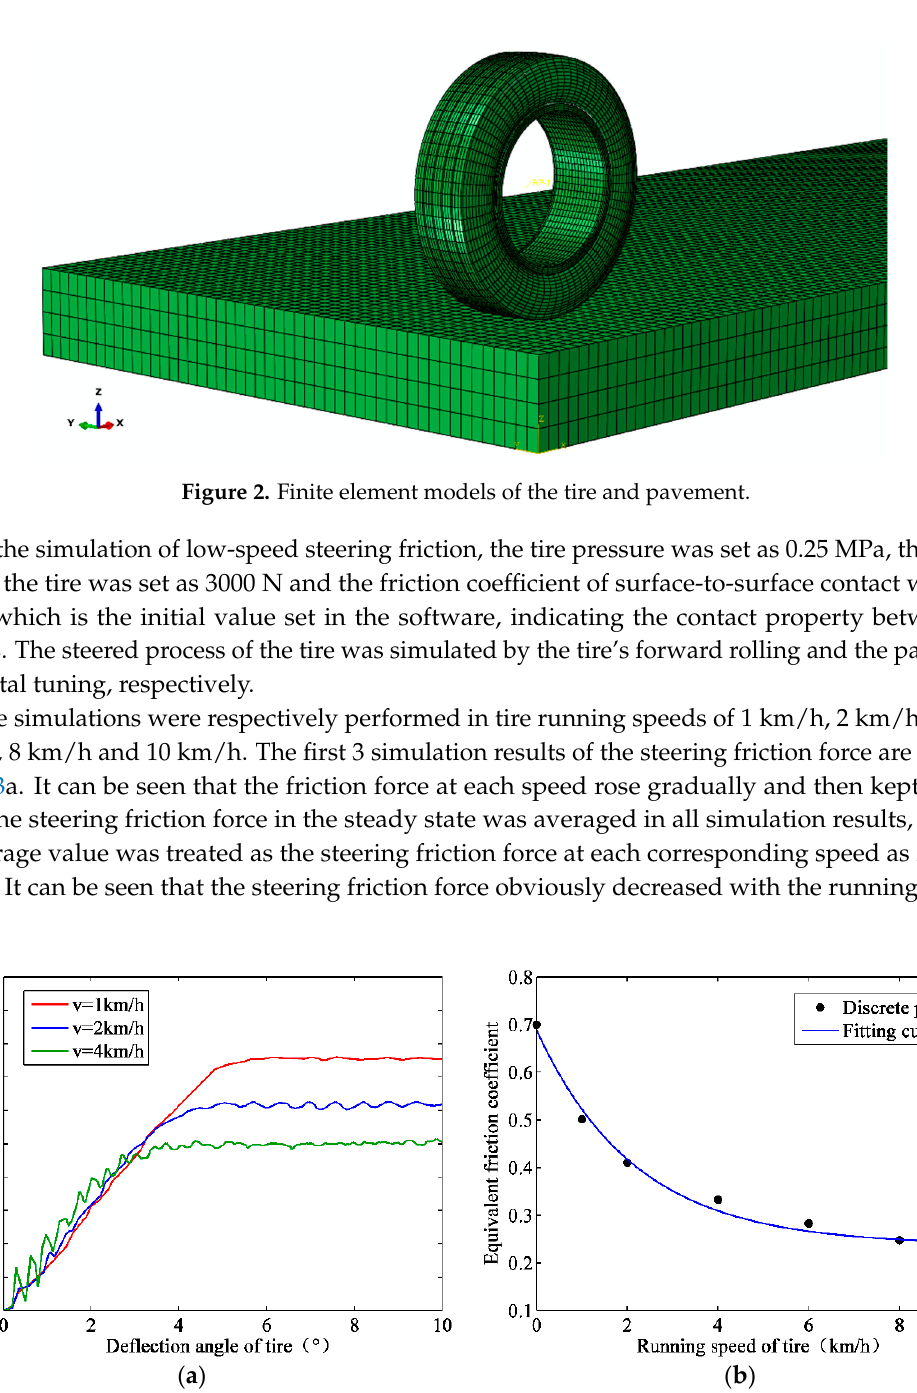
Table 1. Material properties of the tire and pavement.